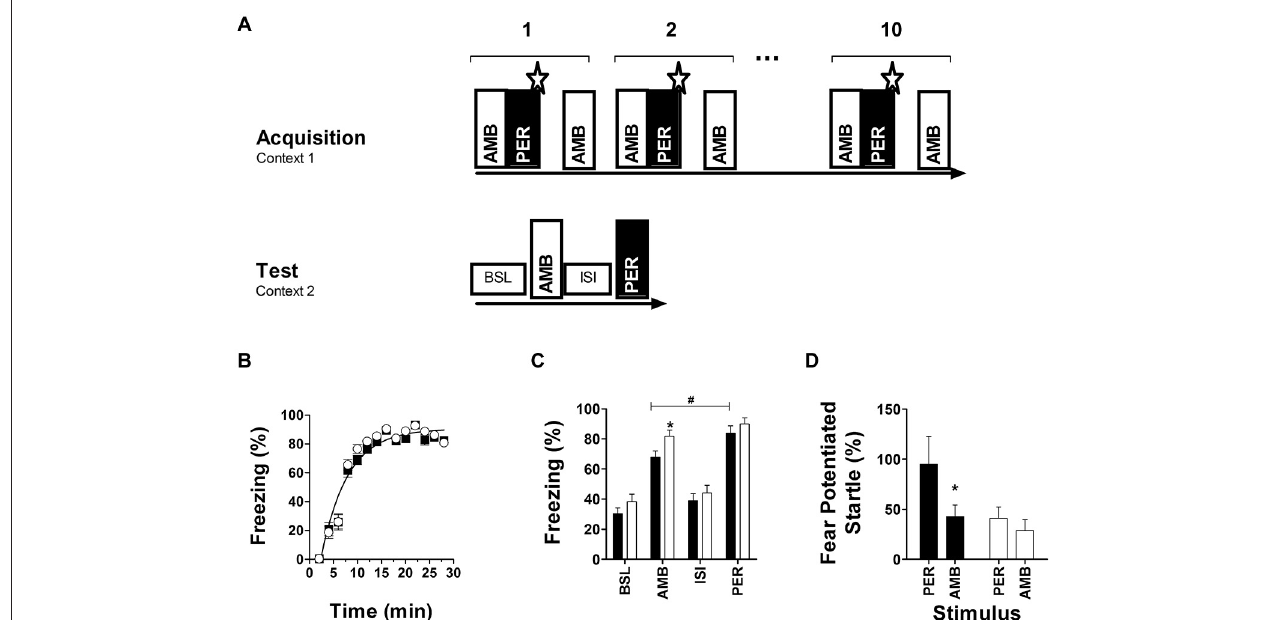
FIGURE 4 | Fear conditioning to ambiguous auditory cues. Two auditory cues were presented during acquisition, and tested 48 h later (A) . During conditioning, both genotypes developed robust freezing responses to negatively reinforced cues (WT, black symbols, n = 18; Nxf7 KO, white symbols, n = 20) (B) . Forty-eight hours later memory strength was tested using freezing as a readout during baseline (novel context, no cues), and presentation of either ambiguous (AMB) or perfect (PER)